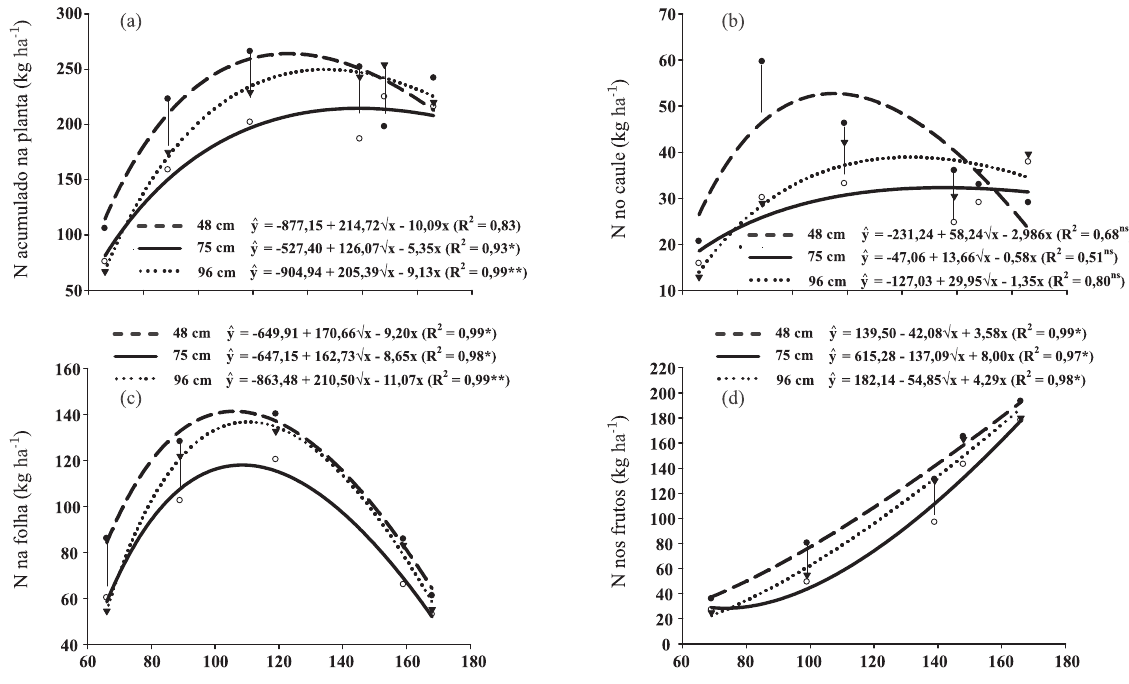
figura 2. Nitrogênio acumulado na planta (a), no caule (b), nas folhas (c) e nos frutos (d) do algodoeiro cultivado nos espaçamentos de 48 ( ), 75 ( ) e 96 cm ( ). A barra vertical representa a diferença mí- nima significativa (dms p <